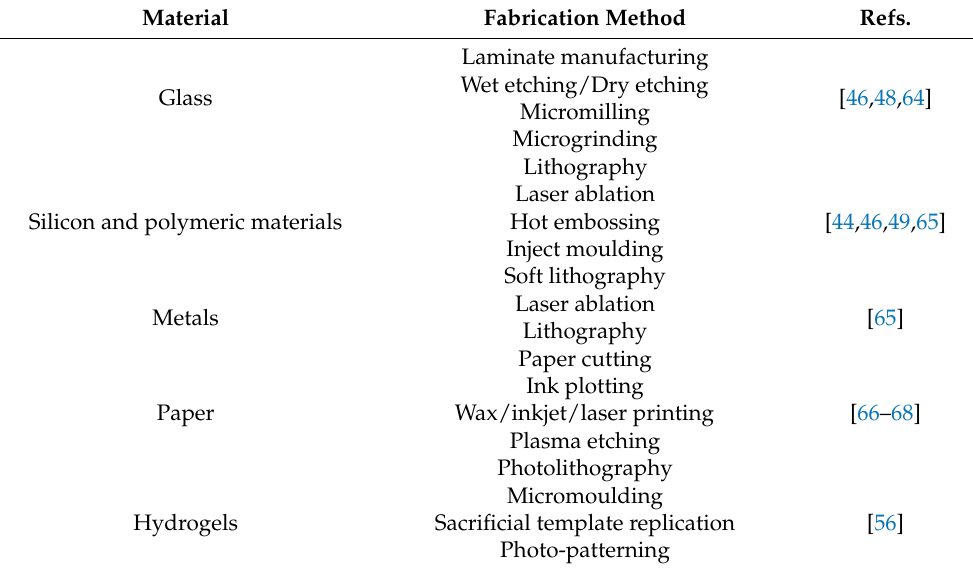
Table 1. A brief overview of traditional MF device manufacturing methods based on construction